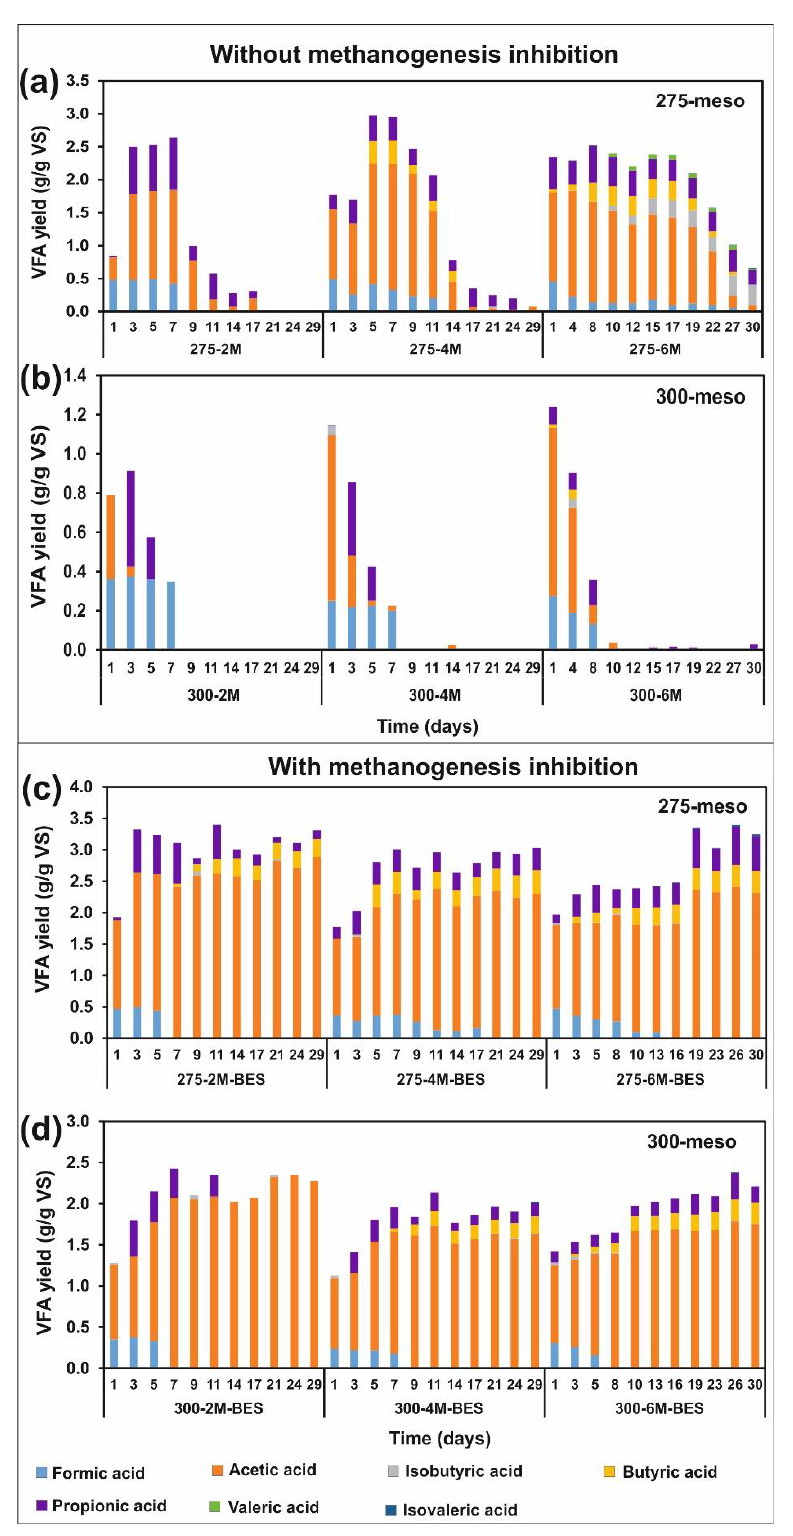
Figure 3. Volatile fatty acids production for the mesophilic process at various substrate loading for torrefaction condensate produced at 275 and 300 °C; ( a , b ) without methanogenesis inhibition and ( c , d ) with methanogenesis inhibition. The 2, 4, 6 represent substrate loading (g VS/L). For example, 275 − 2M − BES is for condensate produced at 275 °C, mesophilic conditions, 2 g VS/L loading and methanogenesis inhibition.